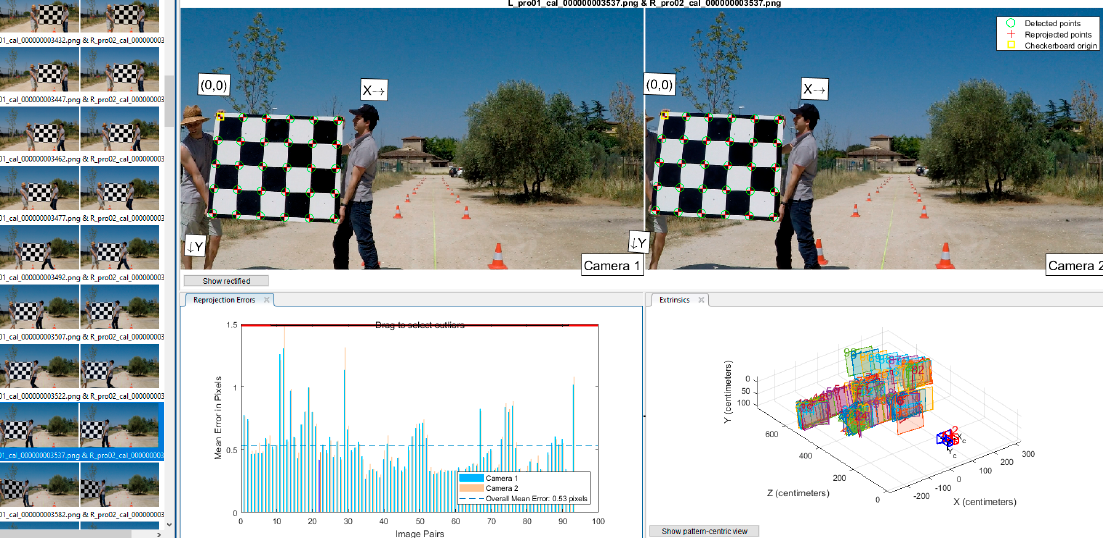
Figure 4. Overview of the graphical user interface of the Matlab Application for the stereo camera calibration.